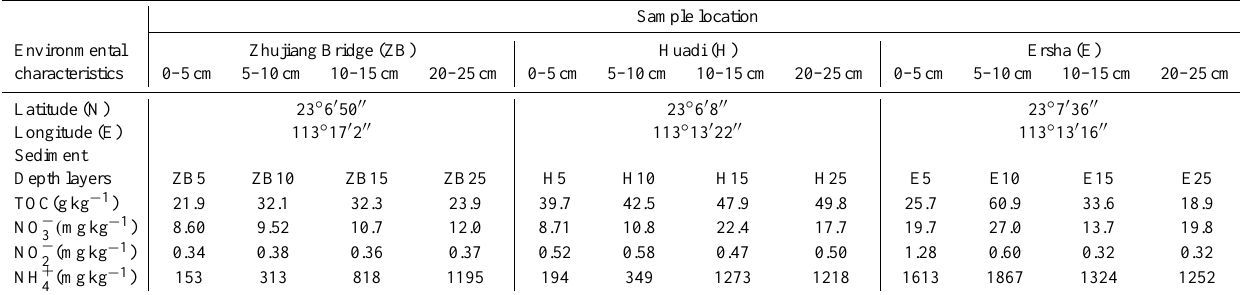
Table 1. Characteristics of sample locations in the Pearl